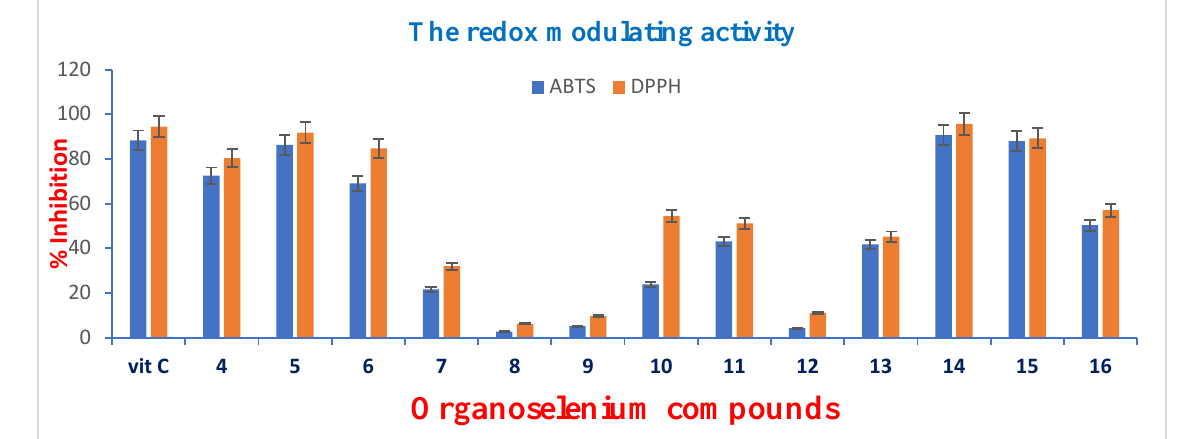
Figure 2. The OSe compounds redox activities assessment using the ABTS and DPPH experiments. All tests are mean ± SD. ABTS experiment: absorbance was followed at 734 nm for OSe compounds (50 µL, 1 mM in MeOH) and ABTS solution (60 µL). DPPH experiment: Absorbance was monitored